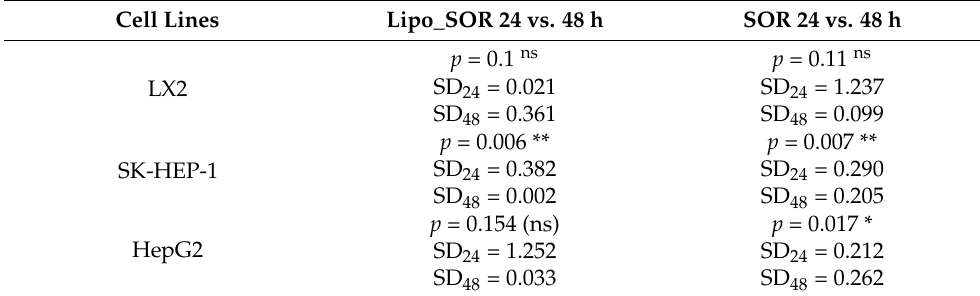
Figure 5. Evaluation of IC50 doses of Lipo_SOR treatment at 48 h. The experiments were performed in duplicates for each cell line. The SOR concentration was calculated based on EE values. Table 3. Statistical analysis of the IC50 concentrations’